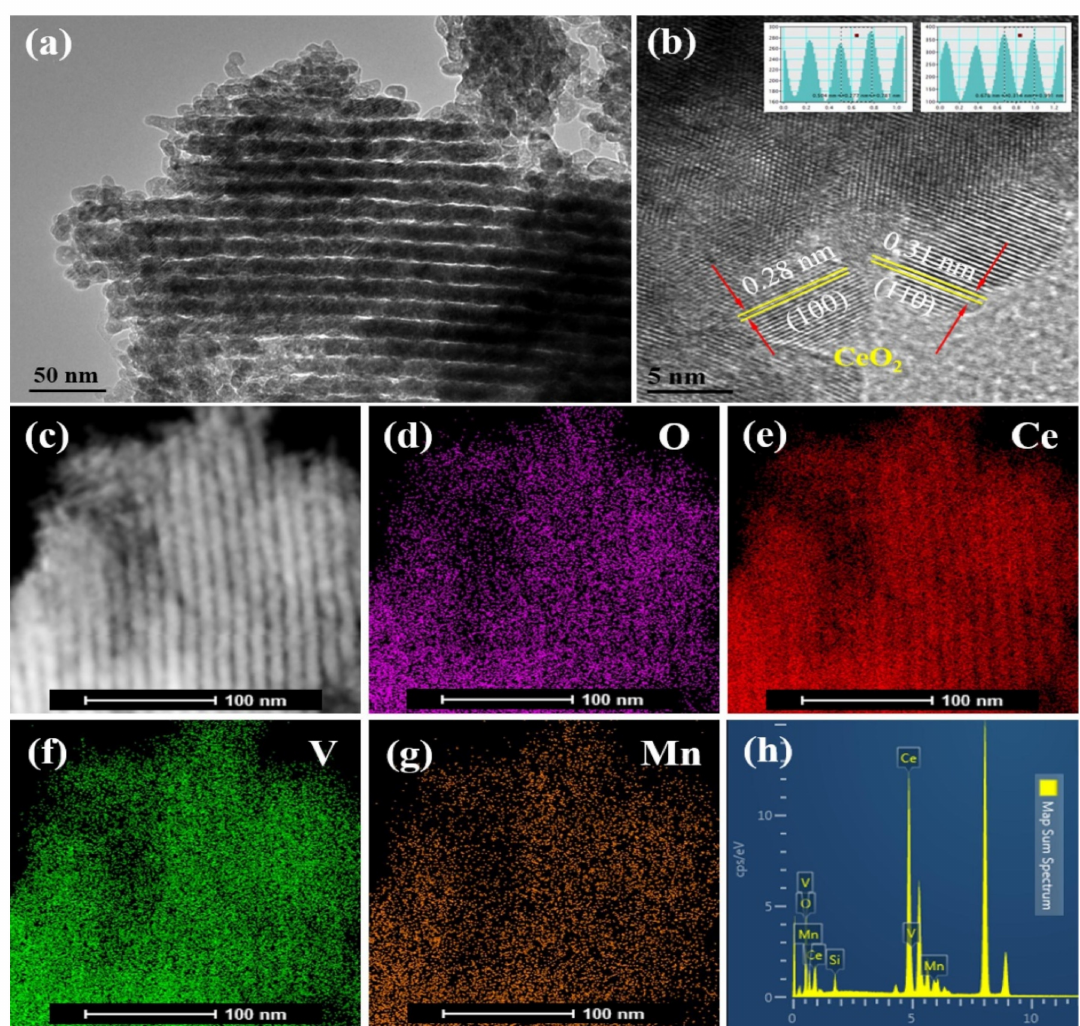
Figure 8. ( a ) TEM images, ( b ) HRTEM images, ( c – h ) energy spectrum analysis (EDS) images and corresponding element mapping of VO x -MnO x /CeO 2 . Reproduced with permission from Reference [30]; copyright (2020),